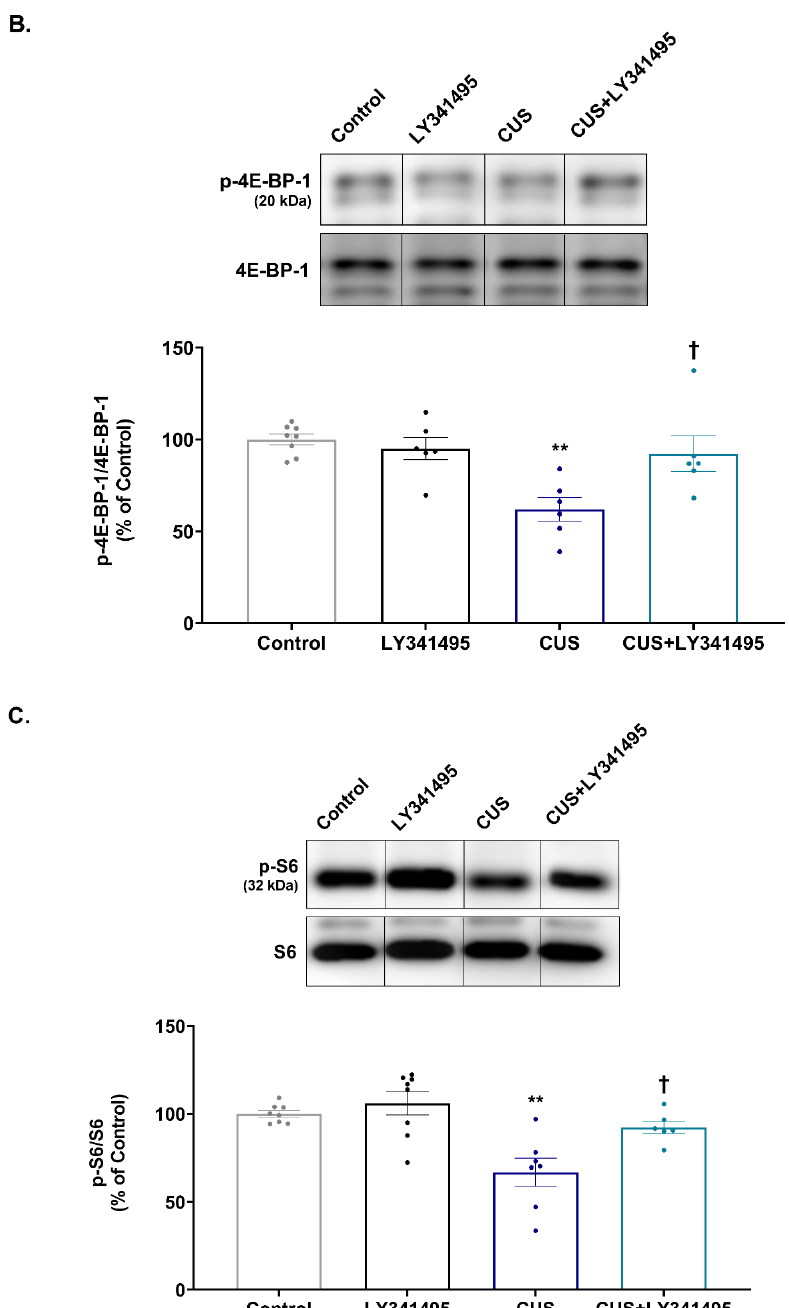
Figure 2. Effects of chronic LY341495 administration on the hippocampal levels of phosphorylated mechanistic target of rapamycin complex 1 (mTORC1), eukaryotic translation initiation factor 4E- binding protein 1 (4E-BP-1), and small ribosomal protein 6 (S6) in chronic unpredictable stress (CUS)-exposed mice. Mice were treated daily with LY341495 (1 mg/kg) or vehicle (1 mL/kg, 0.9% saline) with (the CUS and CUS + LY341495 groups) or without (the control and LY341495 groups) CUS for 4 weeks. The hippocampal levels of phospho-mTORC1 ( A ), phospho-4E-BP-1 ( B ), and phospho-S6 ( C ) were determined by Western blotting, and normalized to the total protein levels. The original images from which we constructed Figure 2A–C are shown as Supplementary Materials. Values represent means ± SEM expressed as percentages of those of the control group. * p < 0.05 vs. the control group, ** p < 0.01 vs. the control group; † p < 0.05 vs. the CUS